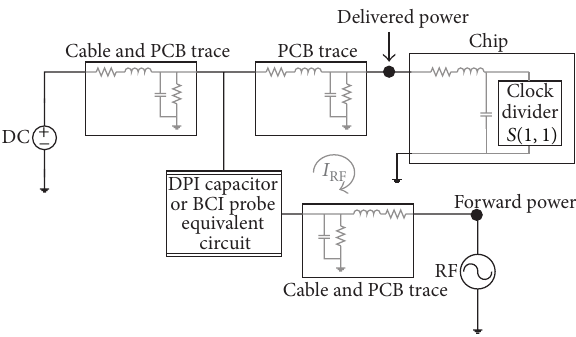
Figure 13: Overall simulation model.